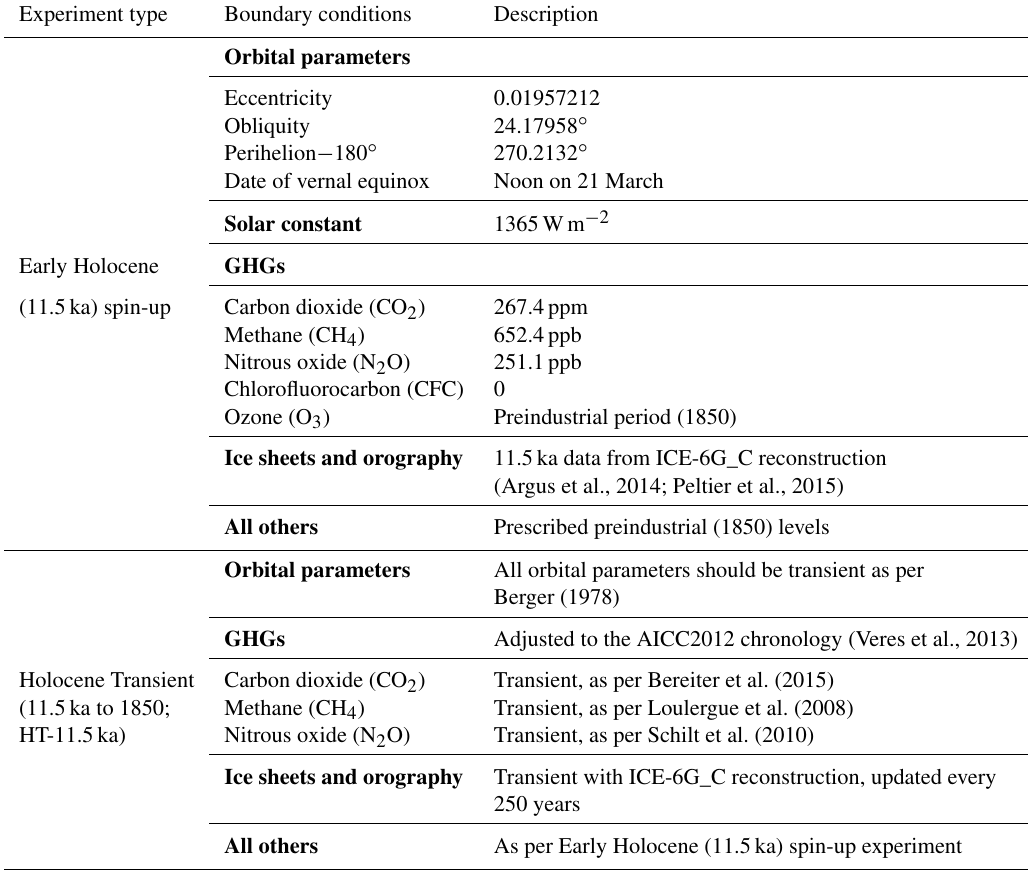
Table 1. Summary of model boundary conditions for the Early Holocene (11.5ka) spin-up and Holocene transient (11.5ka to 1850) ex- periments; see the text for details. Data are available from PMIP4 last deglaciation wiki (PMIP Last Deglaciation Working Group, 2016). Boundary condition group headings are in bold. Note: ppm is parts per million and ppb is parts per